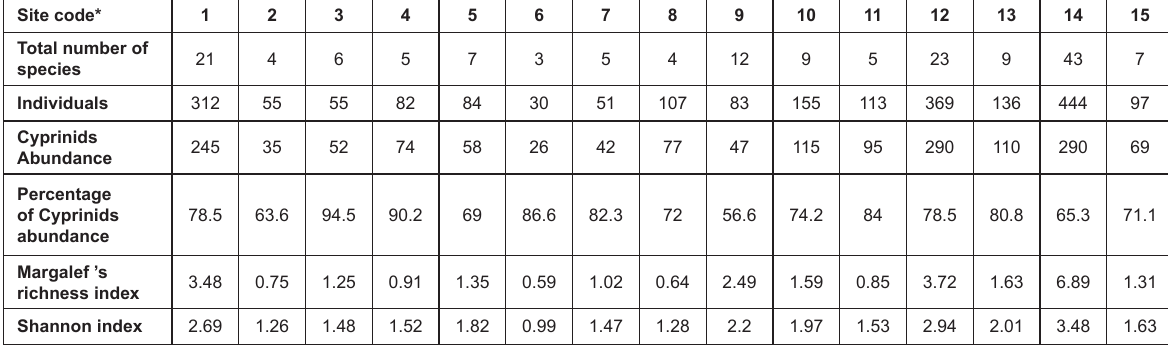
Table 3. Variation in species abundance, cyprinid abundance, Margalef’s richness index and Shannon index in Ken River basin, Madhya